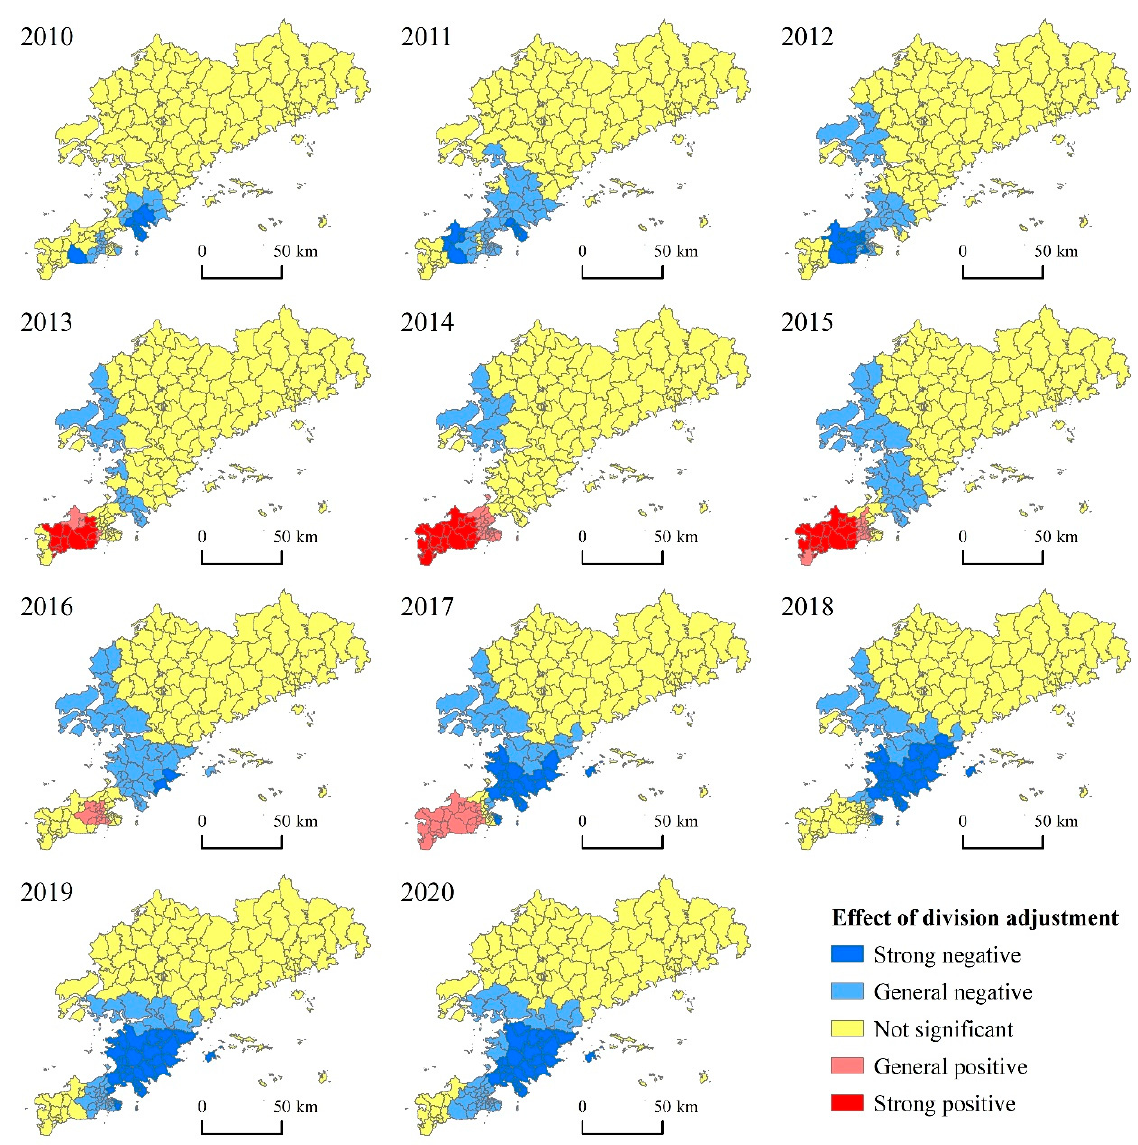
Figure 5. Administrative divisions affected regional differences.